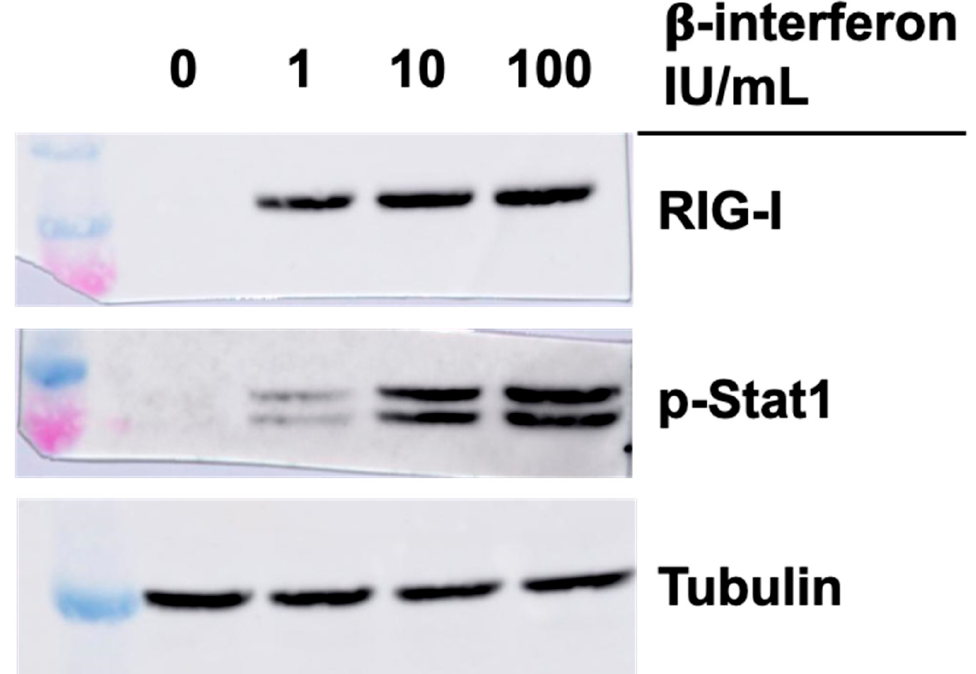
Figure 5. Impact of interferon treatment on RIG-I and phospho-Stat1 in L929 cells. Cells were either mock-treated or treated with varying concentration of commercial β -interferon. Proteins were analyzed by immunoblotting 15 h after treatment, as indicated.